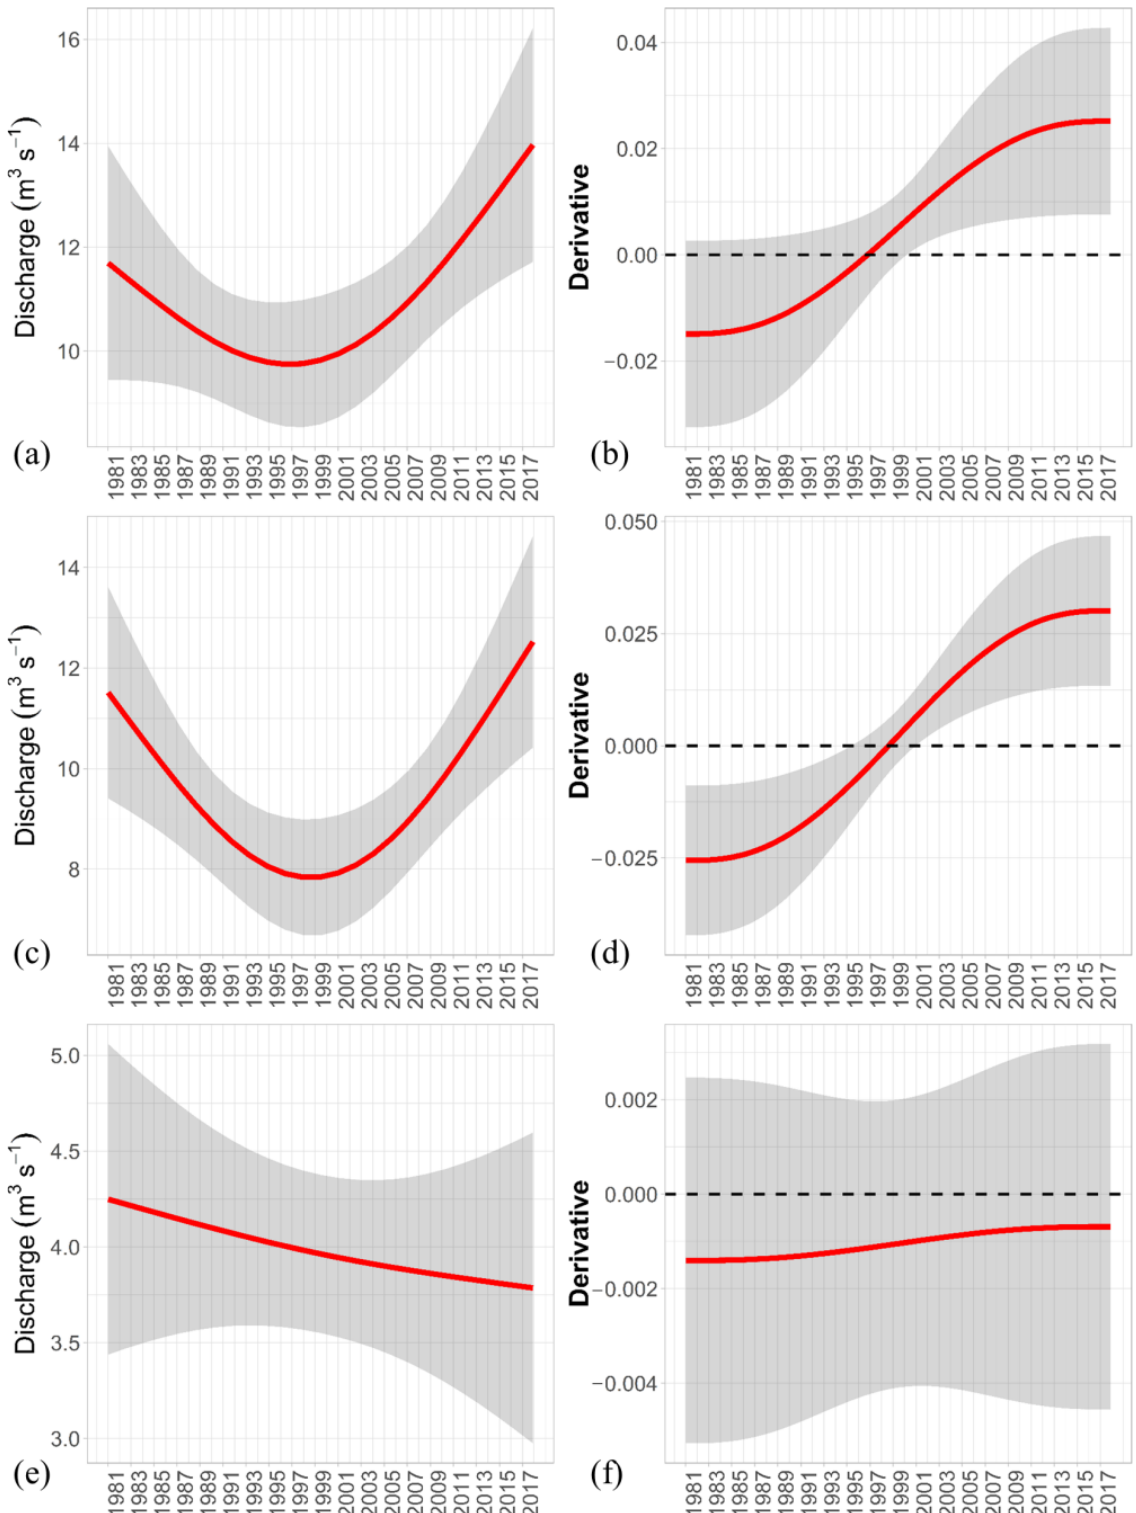
Figure 3. Generalized additive modeled fits of monthly discharge for sub-basins ( a ) PINUP, ( c ) TITAR, and ( e ) MREMA. Subplots ( b , d , f ) show the rate of change for sub-basins PINUP, TITAR, and MREMA, respectively. The shaded area represents the 95% confidence interval.